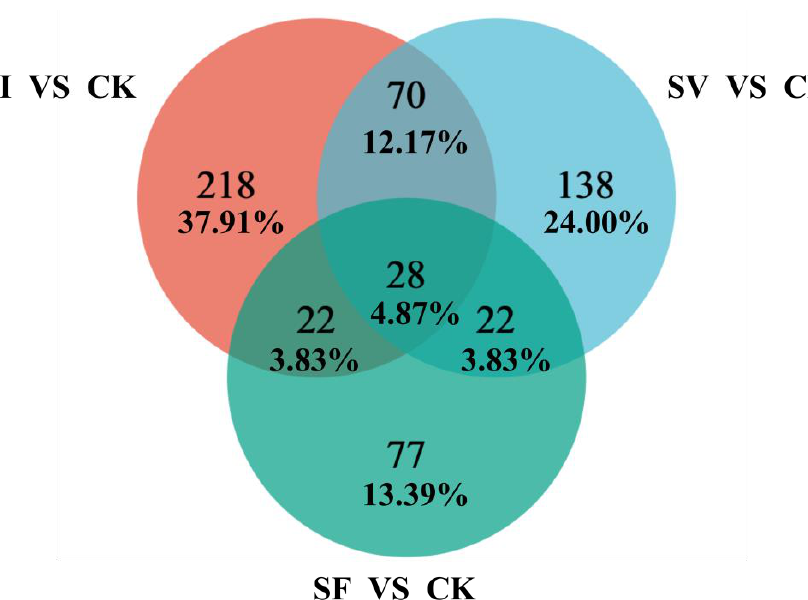
Figure 3. Venn’s diagram of DEGs in comparison groups. RRSV-free BPH were treated with Tween-80 (CK) or Metarhizium anisopliae YTTR (SF) and RRSV-carrying BPH were also treated with Tween-80 (SV) or M. anisopliae YTTR (CI), respectively. After 12 h treatment, RNA-seq was performed. The expression of DEGs among the four treatment groups (CK, SF, SV, and CI) were compared with any two comparison groups. CI vs CK, SV vs CK, and SF vs CK were defined.